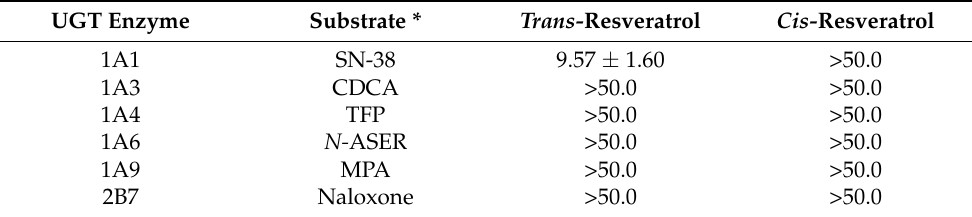
Table 3. Inhibitory effects (IC 50 values) of trans - and cis -resveratrol against six uridine 5 (cid:48) -diphospho- glucuronosyltransferase isoforms (UGTs) in HLMs ( n = 3). UGT